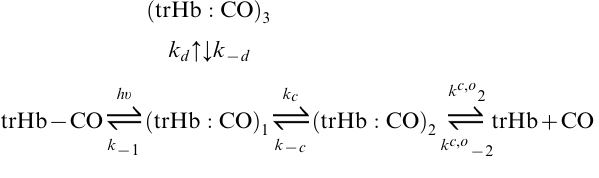
Scheme 1. Extended minimal reaction scheme for